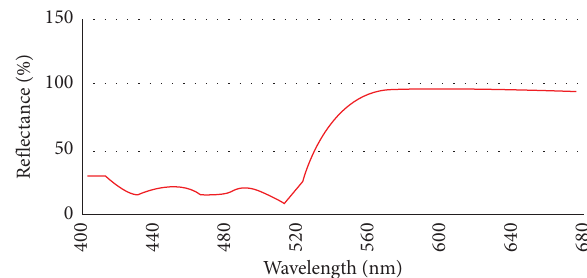
Figure 6: Refectance of F - P mirrors as a function of